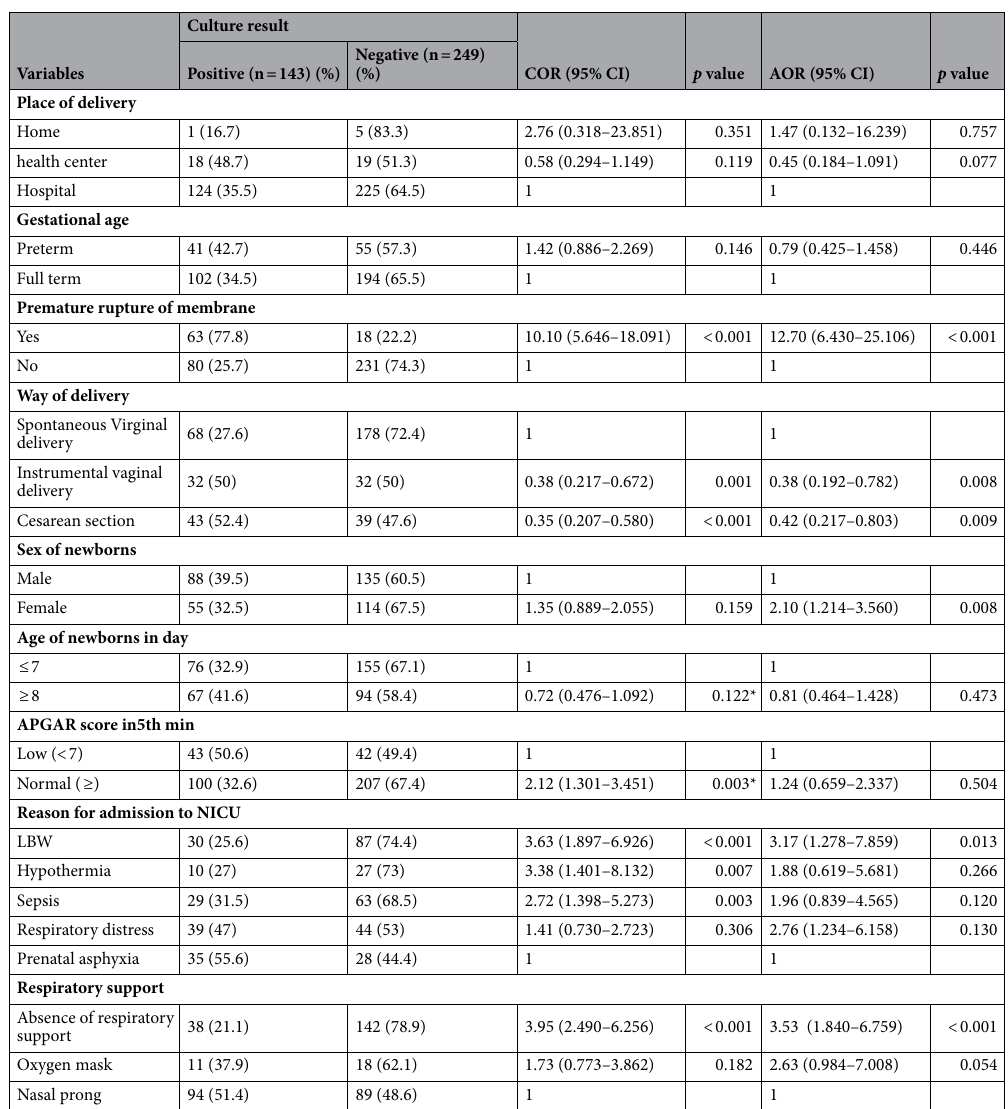
Table 4. Analysis of factors associated with culture-confirmed sepsis among newborns at Hawassa University Comprehensive Specialized Hospital, Hawassa, Ethiopia February 2021 to November 2021. COR crude odds ratio, AOR adjusted odds ratio, CI confidence